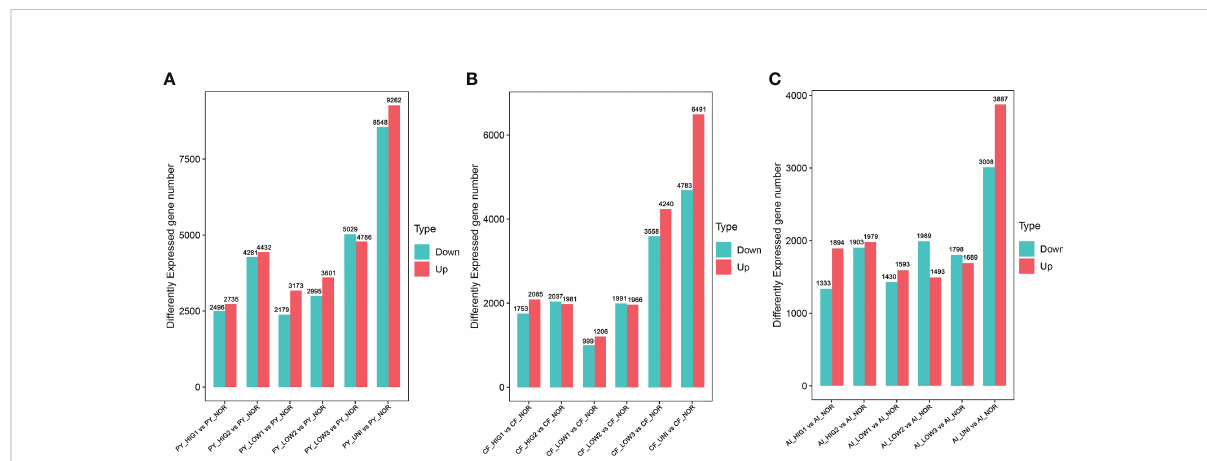
FIGURE 1 Number of DEGs for the Yesso scallop (A) , Zhikong scallop (B) , and bay scallop (C) exposed to heat, hypoxia and heat combined with hypoxia. (PY, Patinopecten yessoensis ; CF, Chlamys farreri ; AI, Argopecten irradians ; HIG1 and HIG2, heat stress at 22 and 25°C, respectively; LOW1- LOW3, hypoxia at DO levels of 6 mg/L, 4 mg/L, and 2 mg/L, respectively; UNI, heat plus hypoxia at 25°C and the 2 mg/L DO; NOR, normal conditions at 15°C and 8 mg/L DO).